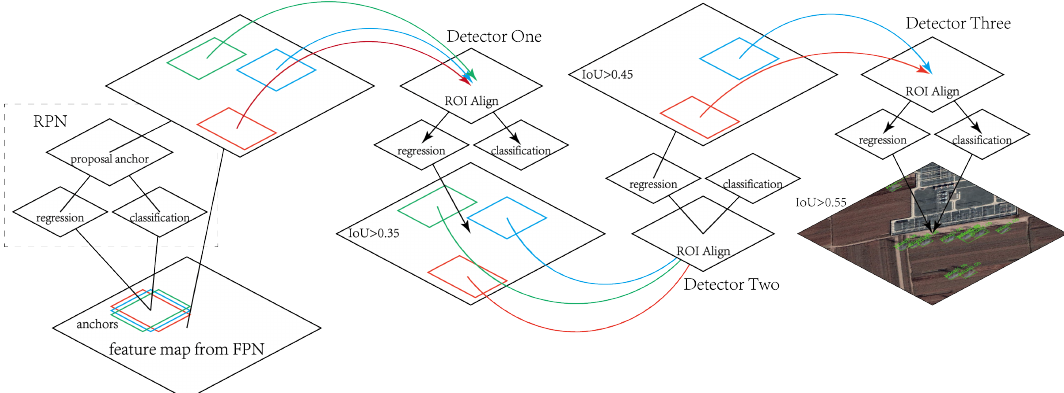
Figure 6. Structure of Cascade R-CNN [20]. The input of Cascade R-CNN is the output of FPN [43]. Tetragons with different colors represent different anchors, while the tetragons on different feature maps with the same color represent the same anchors. RPN (Region Proposal Network) is a fully convolutional network, classifying the anchors to foreground/background and regressing the bounding-box sketchily. ROI is the abbreviation of region of interesting and ROI Align layer [21] is used to reconcile the size of feature maps. IoU is the abbreviation of Intersection over Union, whose details are introduced in Section 4.2. Detectors 1 and 2 use different IoU thresholds and the positive ones are imported to next detector, as shown by the lines of different